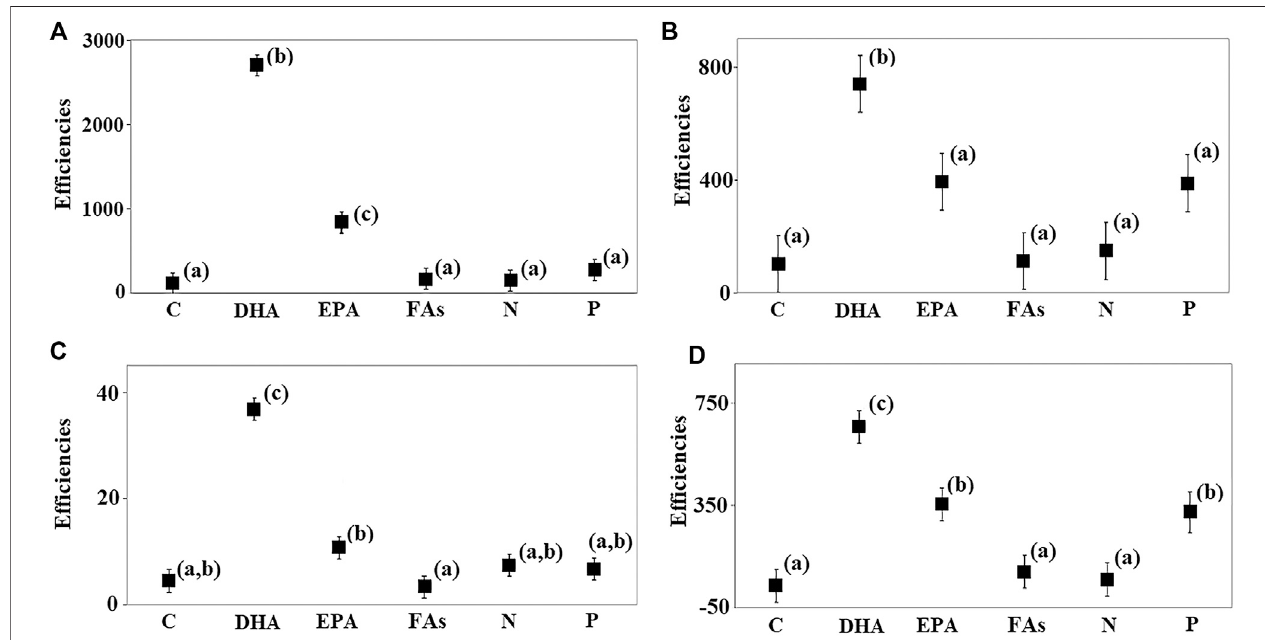
FIGURE 7 | Comparison of the transfer ef fi ciencies of essential substances on day 30 in the 2017 and 2018 experiments. Mean ef fi ciencies were compared using one-way GLM ANOVA ( fi xed factor — substances). Signi fi cant differences were determined by Fisher ’ s LSD post hoc test (C-2017: F (cid:2) 66.1, p << 0.01; ZM-2017: F (cid:2) 6.02, p (cid:2) 0.005;C-2018:F (cid:2) 35.6, p << 0.001;andF-2018:F (cid:2) 17.8, p << 0.001).Differentletters(a,b,andc)designatesigni fi cantdifferences.Errorbars represent the standard errors of the means. (A) C-2017; (B) ZM-2017; (C) C-2018; and (D)